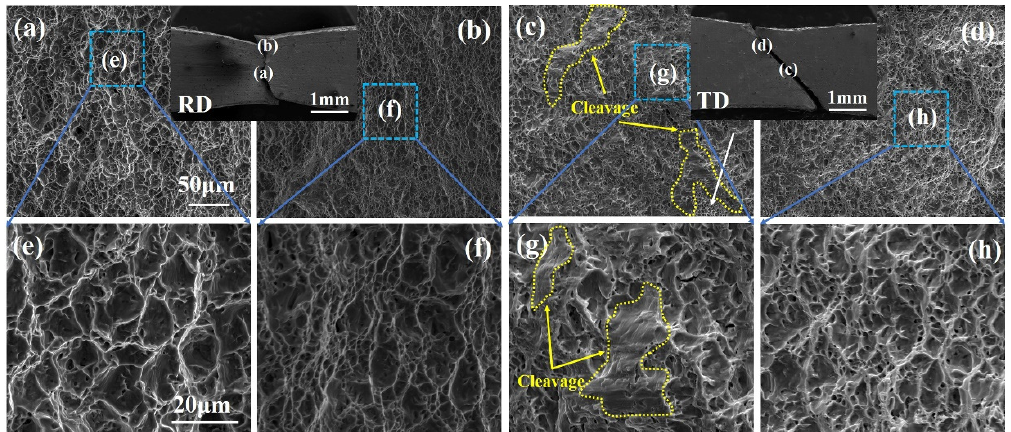
Figure 3. Microscopic fractography of Zircaloy-4 sheet after tensile fracture at 1000× ( a – d ) and the corresponding enlarged map at 4000× ( g – h ). Fractography images at the middle ( a , c , e , g ) and edge position ( b , d , f , h ) of the fracture surface are shown.